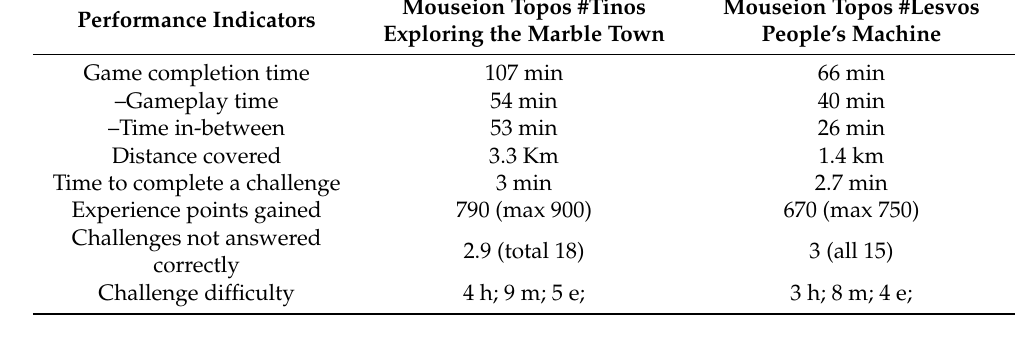
Table 4. Performance indicators in field playtesting of the mobile games. Performance Indicators